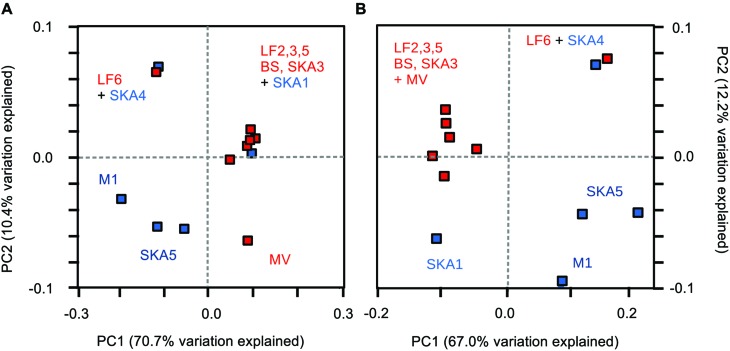
Phylogenetic dissimilarity between samples as assessed by principle coordinate analysis (PCoA) based on weighted UniFrac distances. OTUs were defined at a sequence cut-off of 95% amino acid sequence identity, and PCoA analysis was performed including (A) all OTUs and (B) excluding the two most abundant OTUs from the analysis. Red symbols: seepage sediments, blue symbols: pristine sediments. Sequences from MV enrichments were excluded from the analysis.